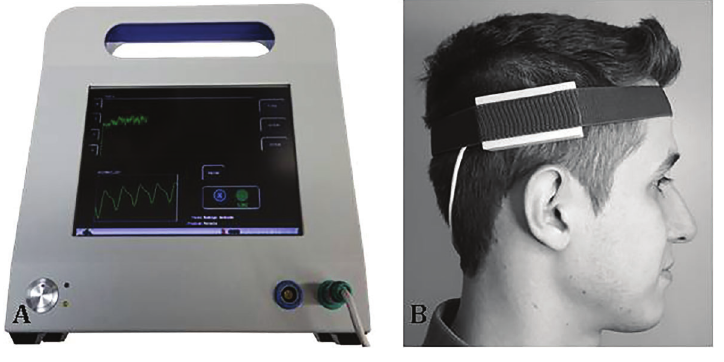
Figure 1. A , Braincare intracranial pressure (ICP) monitor 2000; B , Braincare ICP non-invasive sensor.